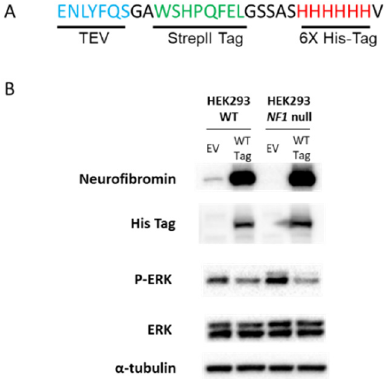
Figure 1. ( A ). Amino acid sequence of tandem affinity purification (TAP) tag cloned in frame with 3’ end of mNf1 cDNA and empty vector control. Blue letters represent the TEV cleavage site. Green letters indicate StrepII tag. Red letters indicate 6XHis tag. ( B) . Western blots showing neurofibromin protein levels in wildtype (WT, left) and NF1 null HEK293 cells (right). Cells were transfected with either the Empty Vector (EV) or the tagged mNf1 cDNA (WT) and probed with antibodies indicated. The first row of immunoblots shows the neurofibromin levels. The second row shows the functional His tag in only the lanes transfected with mNf1 (WT). The third row shows pERK. Total ERK levels are shown in the fourth row. Fifth row shows α -Tubulin for normalization of NF1 levels. Our initial experiments utilized the mNf1 tagged cDNA in both NF1 -replete or wildtype (WT) HEK293 cells and NF1 -deficient (null) HEK293 cells. We noted that when we utilized HEK293 WT cells, we were able to affinity purify an endogenous human neurofibromin protein fragment with the tagged mNf1 cDNA. The human NF1 protein fragment identified by MS is depicted in Figure 2A aligned with the mouse sequence. We were able to make this species determination based on one of the few amino acid changes between the human and murine protein sequences. Note, that the human T2489 is encoded by alanine in mouse. Due to the high homology between human and mouse neurofibromin proteins, we were only able to identify one fragment with sequence variation. This data suggests that neurofibromin may oligomerize with other neurofibromin proteins within the cell. In order to show that neurofibromin oligomerizes, we co-transfected a halo-tagged human NF1 cDNA along with the tagged mNf1 cDNA into the HEK293 NF1 null cells, and then affinity purified with either the Strep tag or Halo tag. We confirmed that neurofibromin oligomerizes via these reciprocal immunoprecipitations (Figure 2B). We are able to detect halo-tagged hNF1 protein after AP with Strep tag and His-tagged mNf1 after AP with halo-tagged hNF1.